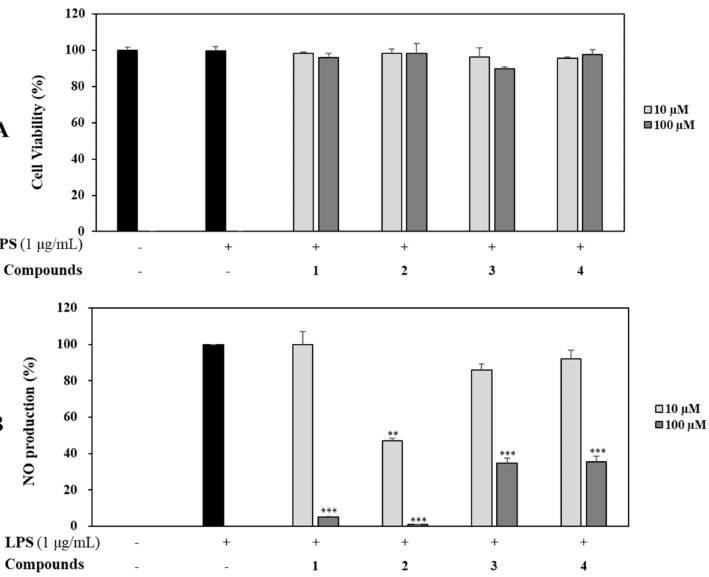
Figure 4. Effects of compounds on cell viability and NO production. ( A ) RAW 264.7 cells were treated with compounds 1 − 4 (10 and 100 µ M) for 1 h and stimulated with LPS (1 µ g/mL) for 16 h. Cell viability and NO production were detected using MTT assay and Griess reagent, respectively. ( B ) Nitrite concentrations of untreated and LPS-treated controls, respectively. Each experiment was performed in triplicate. The data are represented as mean ± SD. ** p < 0.01, *** p < 0.001 vs. LPS-treated